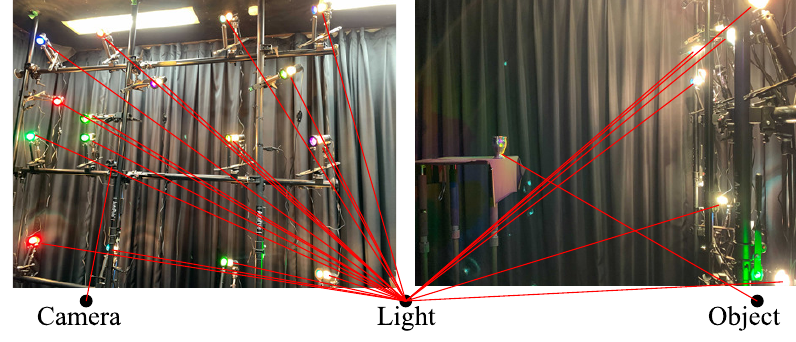
Figure 6. Experimental apparatus.